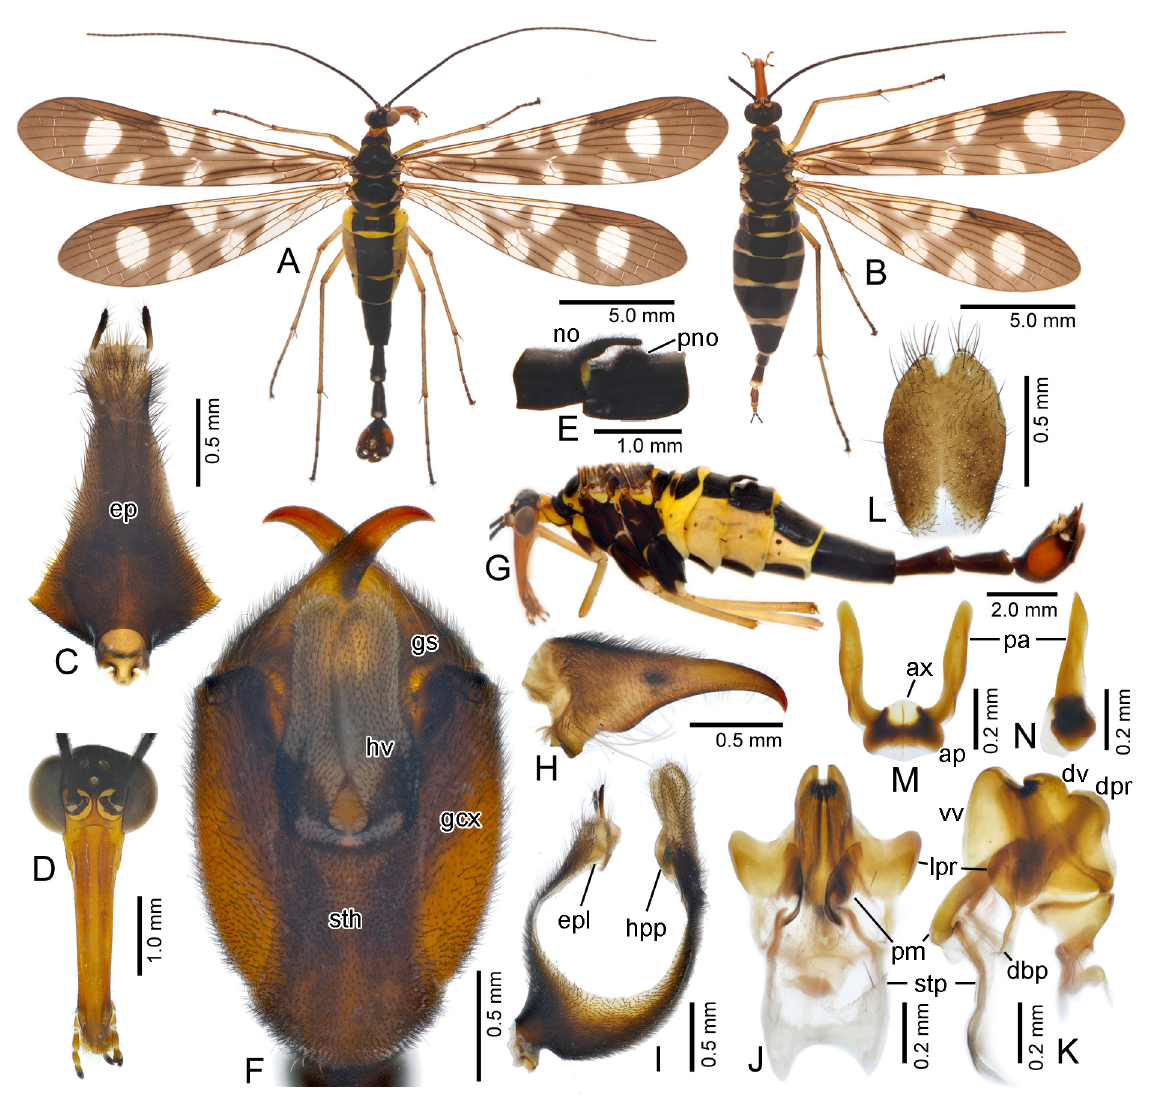
Fig. 5. Neopanorpa ocellaris (Navás, 1908). A , C ‒ K . Male. A . Habitus, dorsal view. C . Epandrium, dorsal view. D . Head, frontal view. E . T3 and T4, left-lateral view. F . Genital bulb, ventral view. G . Habitus, left-lateral view. H . Left gonostylus, ventral view. I . Epandrium and hypandrium, left- lateral view. J – K . Aedeagal complex, ventral and right-lateral views, respectively. – B , L ‒ N . Female. B . Habitus, dorsal view. L . Subgenital plate, ventral view. M – N . Medigynium, ventral and right-lateral views,